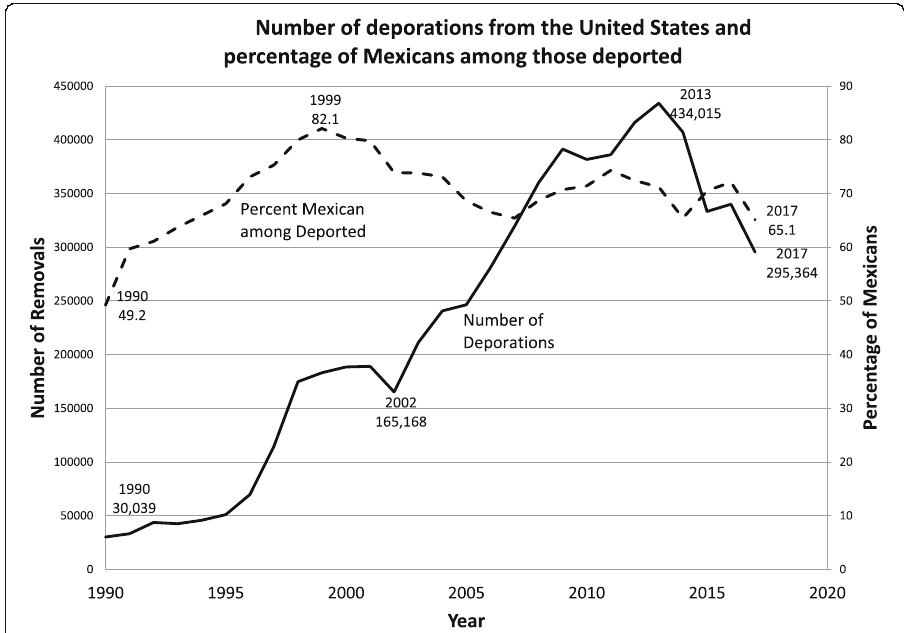
Fig. 17 Number of deporations from the United States and percentage of Mexicans among those